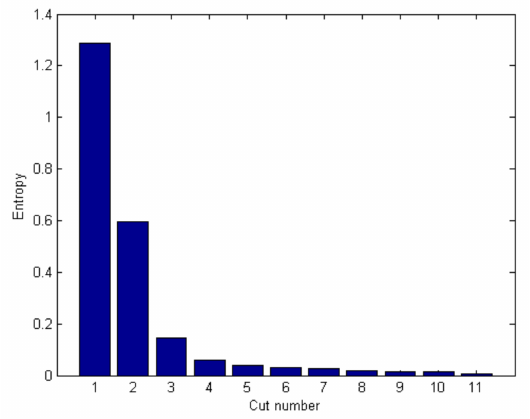
Figure 1. Results of entropy